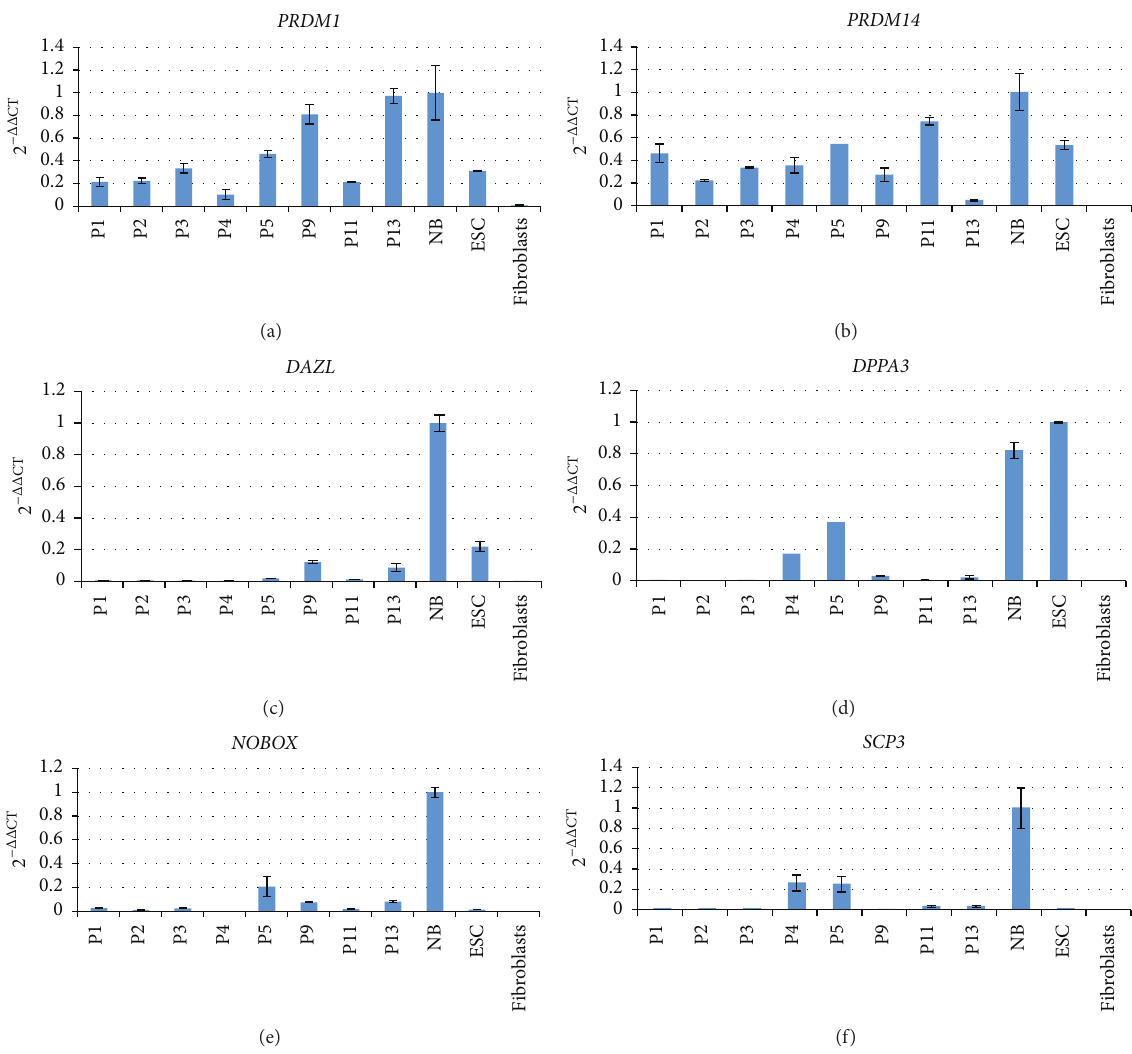
Figure 4: Expression of additional germ cell markers in OCCs. PRDM1 and PRDM14 are necessary for germ cell specification and are expressed in all OCC passages in the range of the controls. DAZL and DPPA3 are also necessary for germ cell specification and were detectable only in few samples. NOBOX is a female-specific germ cell marker and was detectable at relatively low levels in most samples. SCP3 is a meiosis marker and was detectable only in some samples at variable levels. In general, the germ-cell-specific markers were very low or absent during the first three